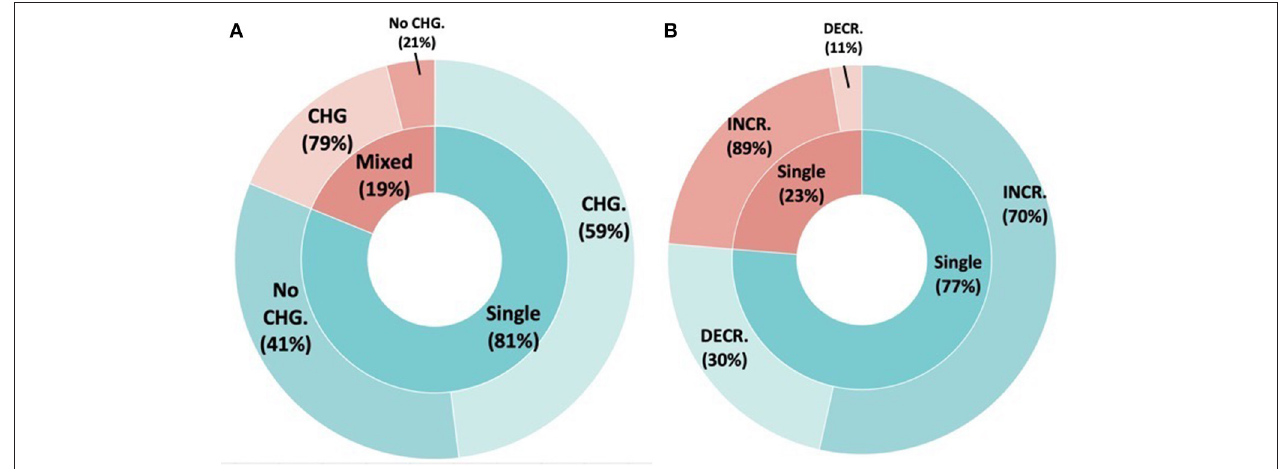
FIGURE 4 | The effect of inoculum diversity on the resident bacterial communities. (A) The inner rings demonstrates bioinoculant diversity category (single species vs. mixed species). The outer ring demonstrates the proportion of studies that found on the resident bacterial community diversity. (B) Boxed pie chart demonstrates the directional community changes (increased vs. decline) per inoculant type (blue = single species inoculants and red = mixed species inoculants) for the studies that showed SMC changes following inoculation.